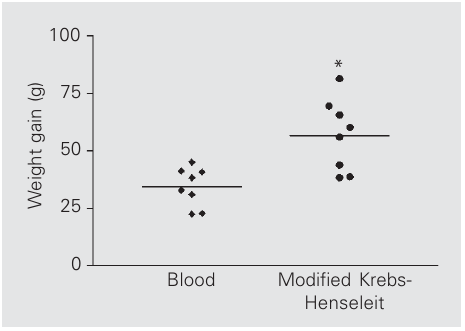
Figure 1. Heart weight gain af- ter 90 min of perfusion. Hearts were perfused with modified Krebs-Henseleit solution (N = 8) or blood perfusate (N = 8). The horizontal lines indicate the mean. *P<0.05 compared to blood perfusate (Student t